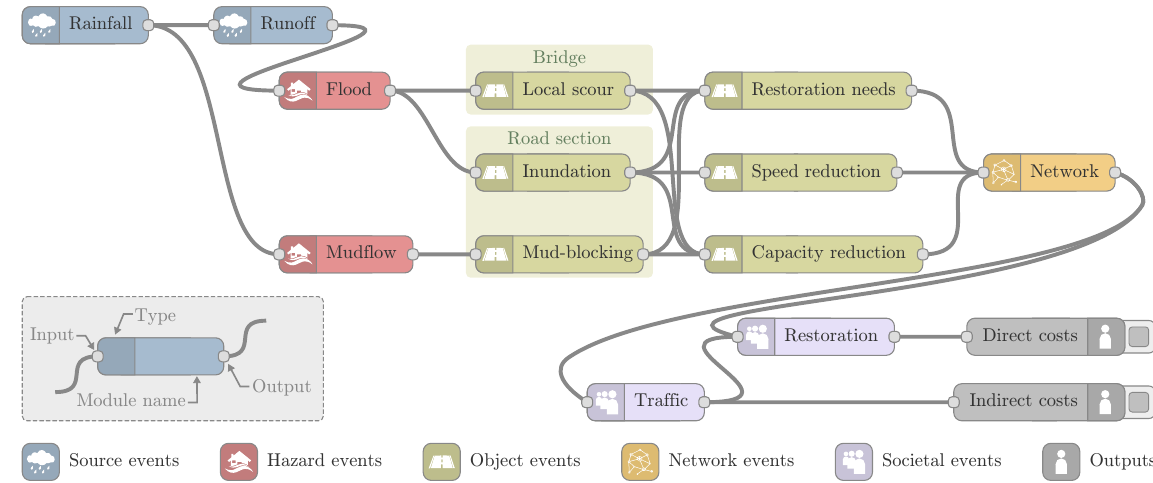
Figure 1. Schematic overview of the modules used for the application. Modules, represented by nodes with certain inputs and outputs, are related to the events that need to be modeled to estimate risk. The assessment starts with the modeling of a random rainfall and its corre- sponding runoff . Estimated discharge values at river stations of interest are used to simulate the flood propagation, including the inundation of the area. A mudflow can be randomly triggered during the rainfall if accumulated precipitation values exceed certain thresholds. In the next step, expected damages (i.e., bridge local scour , road section inundation , road section mud-blocking ), functional losses (i.e., speed reduction , capacity reduction ), and restoration needs (i.e., restoration cost, restoration time) are determined for each affected object in the network. The updated states of individual objects help define the new state of the entire network . The traffic through the network is then simulated. Restoration interventions are executed to enable the network to provide an adequate level of service again by changing the state of damaged objects. The costs for the restoration are accounted as direct costs , while the costs related to additional vehicle travel time through the network and missed trips are accounted as indirect costs